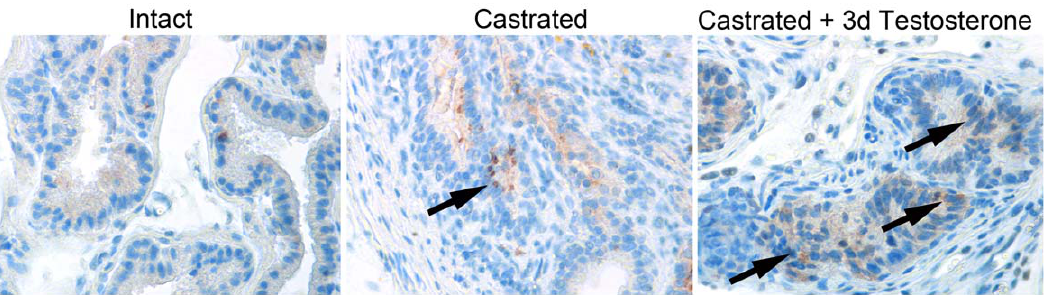
Figure 4. MSCs were recruited to the prostate during regrowth. GFP-MSCs (brown) were recruited to the prostates of mice at the indicated time points during regrowth. MSC recruitment was focal, and quantitation was performed for selected fields of view with detectable MSCs. Oneway Welch ANOVA allowing for unequal variances was used to test differences between the experimental groups and the intact group (n=20), followed by a two-sample t tests with unequal variances. The omnibus of statistic from the ANOVA was 89.0 (p , 0.0001). Two-sample t tests with unequal variances tests showed a statistically significant increase between intact (mean =7.25 cells per field of view) and castrated (mean =25.75 cells, probability , 0.0001) and castrated + 3dT (mean =38.55 cells, probability , 0.0001).